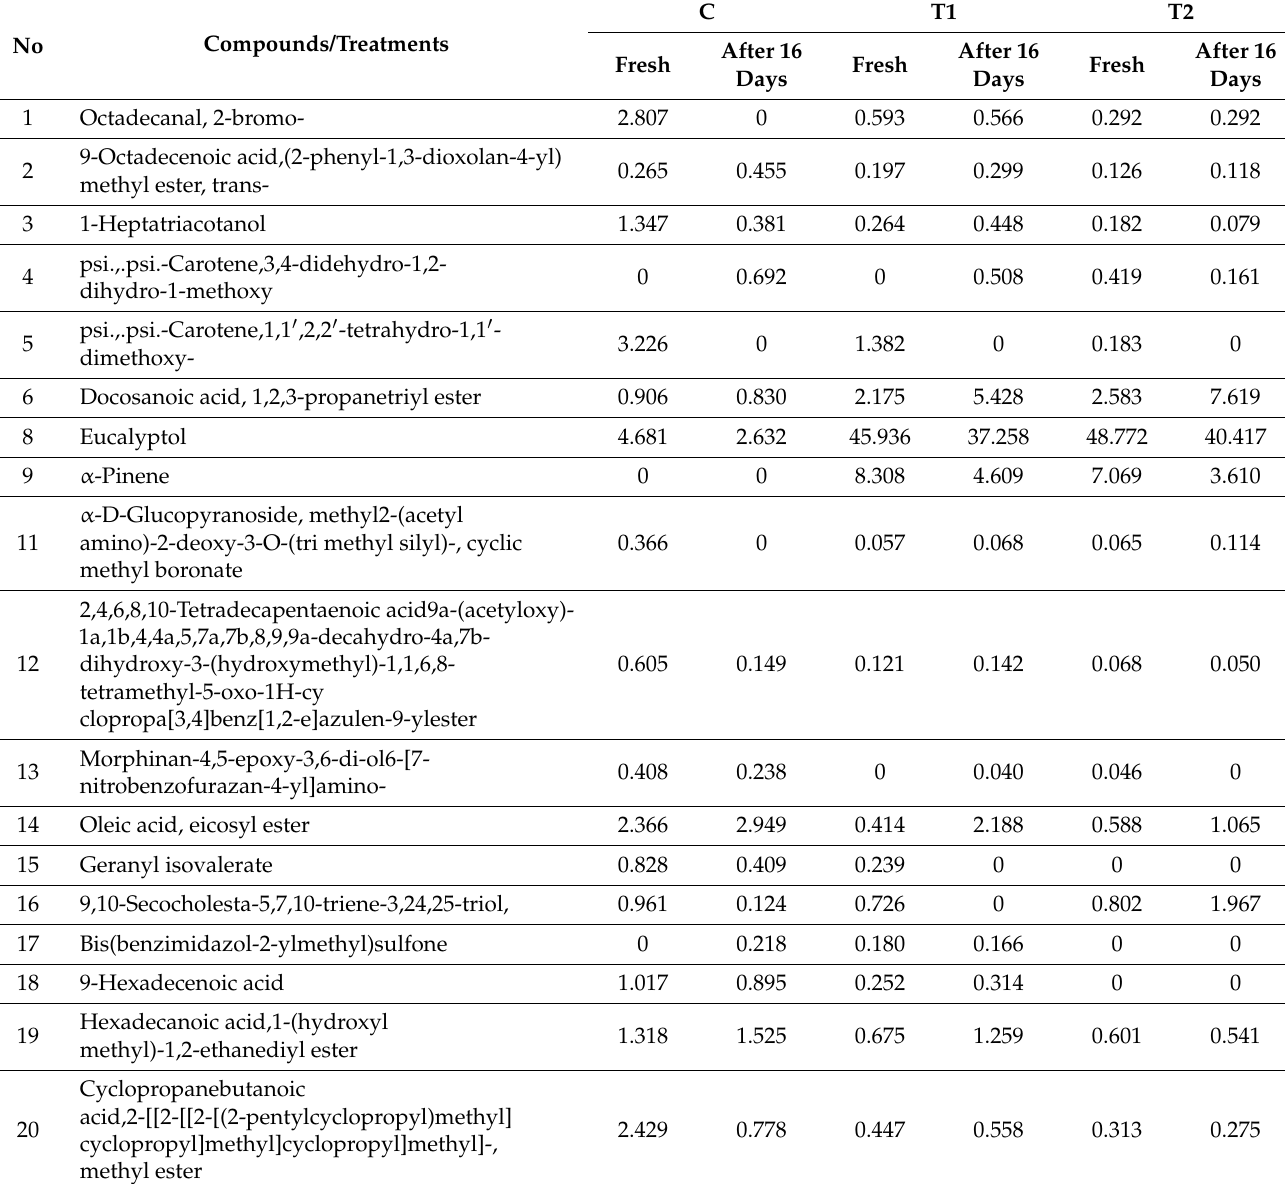
Table 3. Gas chromatography (GC)-Mass Spectrometry (MS) analysis results of SLY samples without and with REO